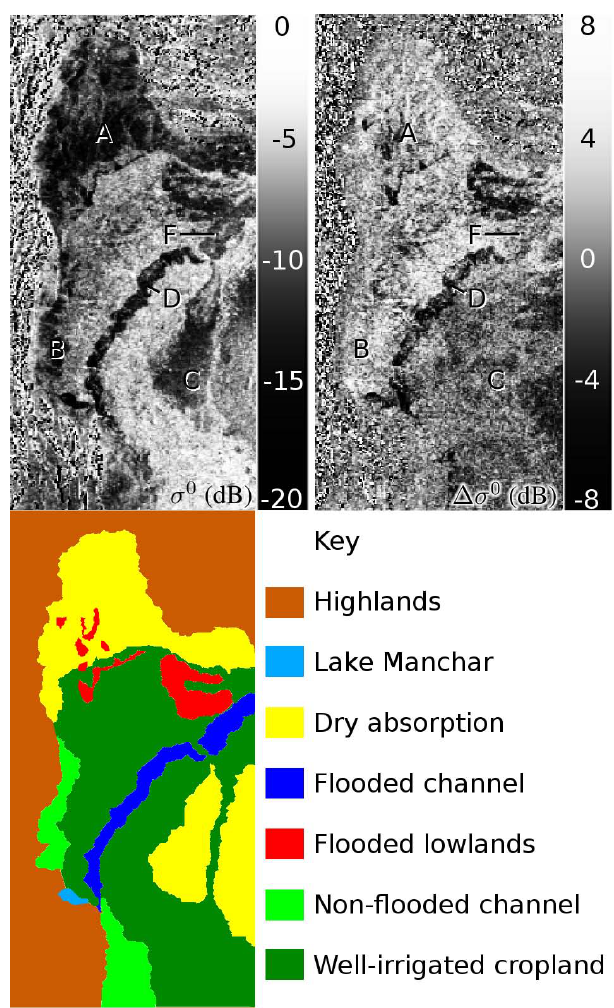
Fig. 8. The region between Jacobabad and Nawabshah in mid Au- gust 2010. The image on the left shows backscatter values in deci- bels. Smooth open water is commonly represented by values of around − 16dB or below. The image on the right shows the same data, with the values from the previous cycle along the same orbit track having been deducted. A better understanding of the true ex- tent of flooding can be discerned by a difference of around − 4dB in this image.